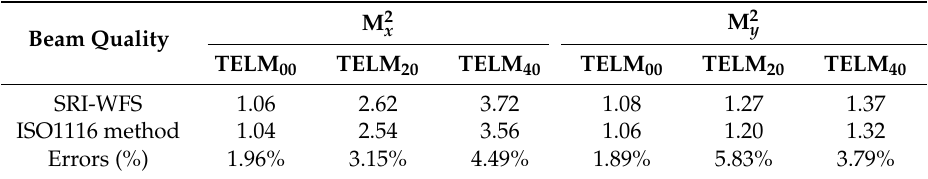
Figure 8. M 2 -curves of Hermite-Gaussian-like modes in TELM 00 , TELM 20 , and TELM 40 . Here, the numbers 1, 2, 3, and 4 are the circular scale for the M 2 -curve. Table 1. The measurement results of M 2 factor for Hermite-Gaussian-like modes TELM 00 , TELM 20 , and TELM 40 with the proposed SRI-WFS method and the ISO1116 standard based beam quality analyzer.